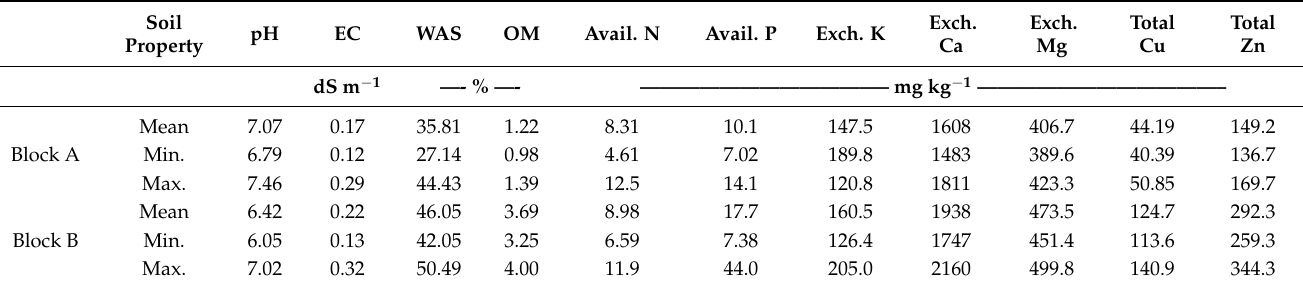
Table A1. Basic properties of the soils in block A and block B.